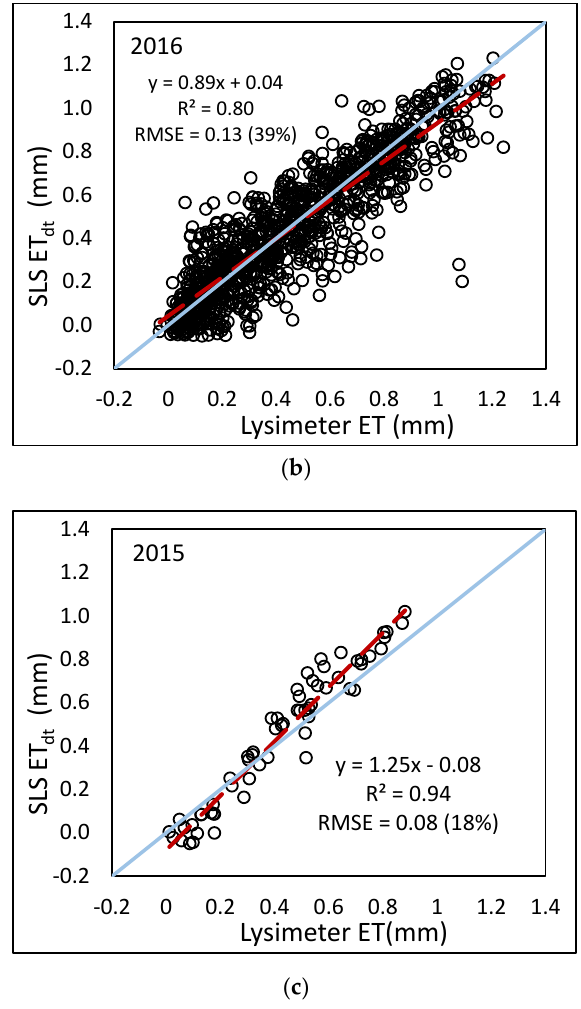
Figure 10. Comparison of daytime hourly ET from the SLS to lysimeter data using ( a ) 2015–2016 combined data; ( b ) 2016; ( c ) 2015.